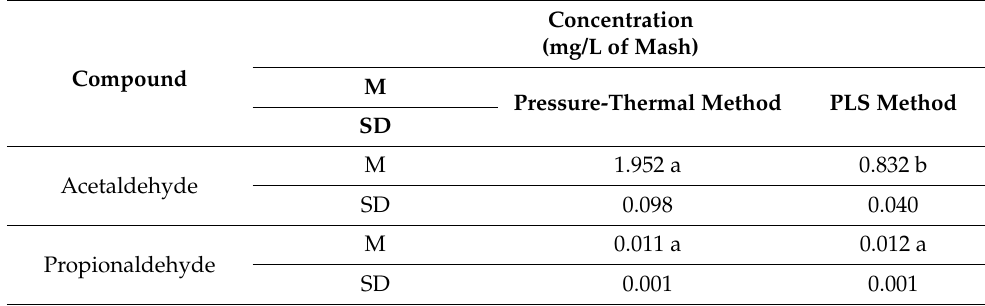
Table 5. Aldehydes in the sweet rye